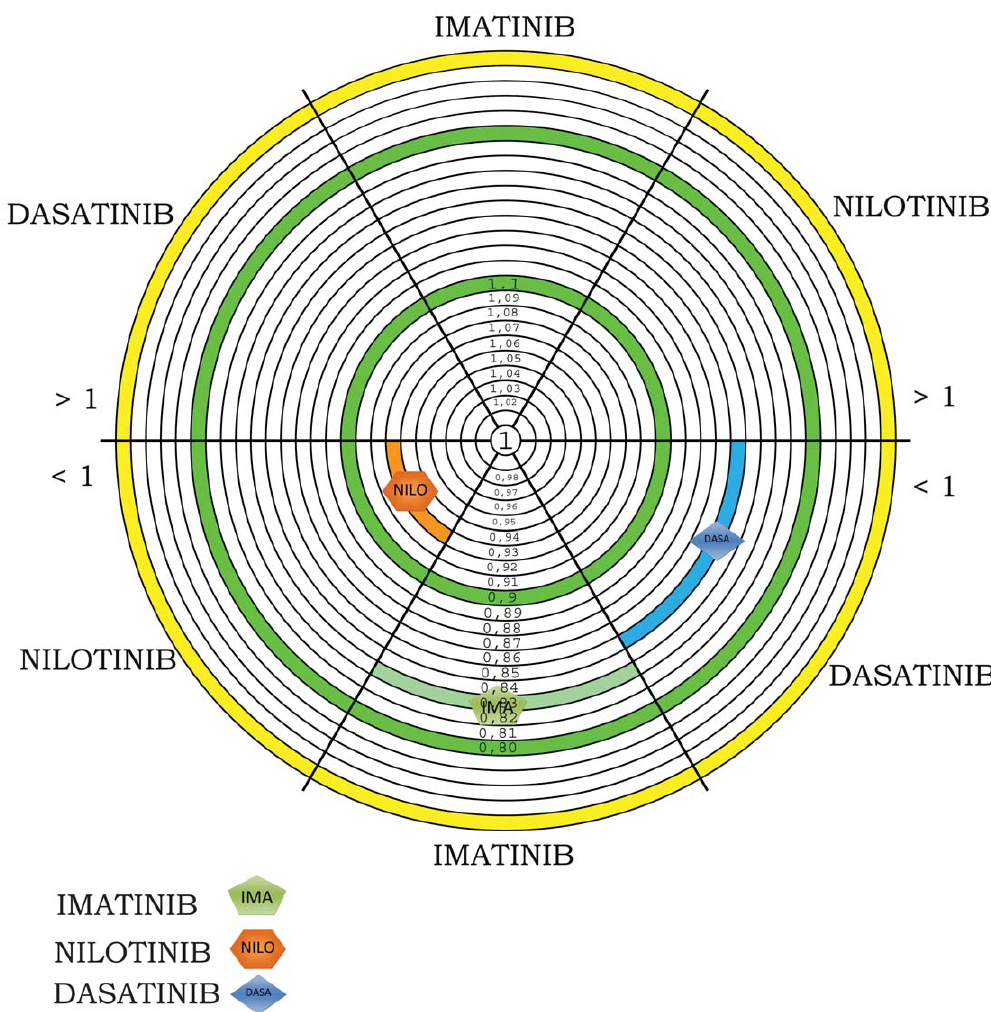
Figure 1. Medication adherence for Imatinib, Nilotinib and Dasatinib.